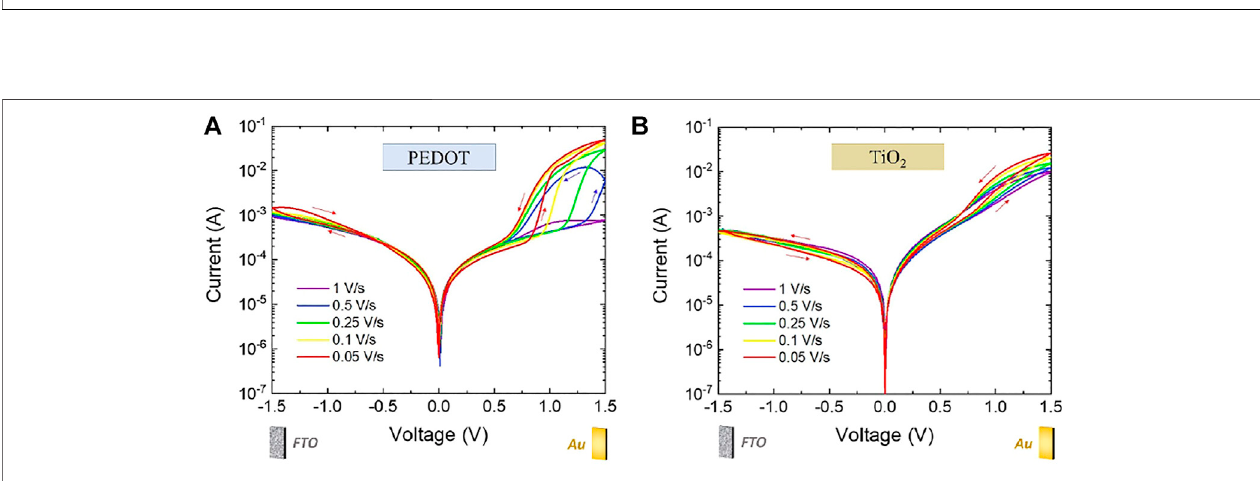
FIGURE 9 | Current − voltage characteristics of the (A) FTO/PEDOT:PSS/MAPI/Au and (B) FTO/c-TiO conditions for 5 different scan rates.